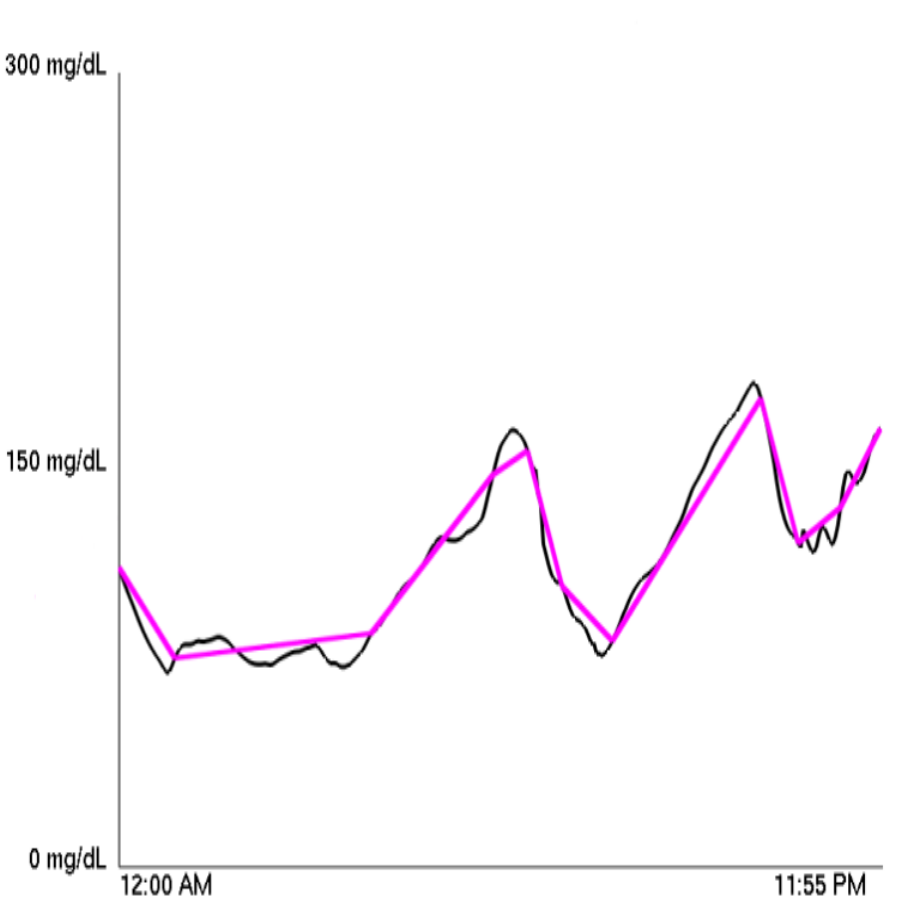
Figure 1. PLA (purple) of a blood glucose graph (black). The PLA factor is